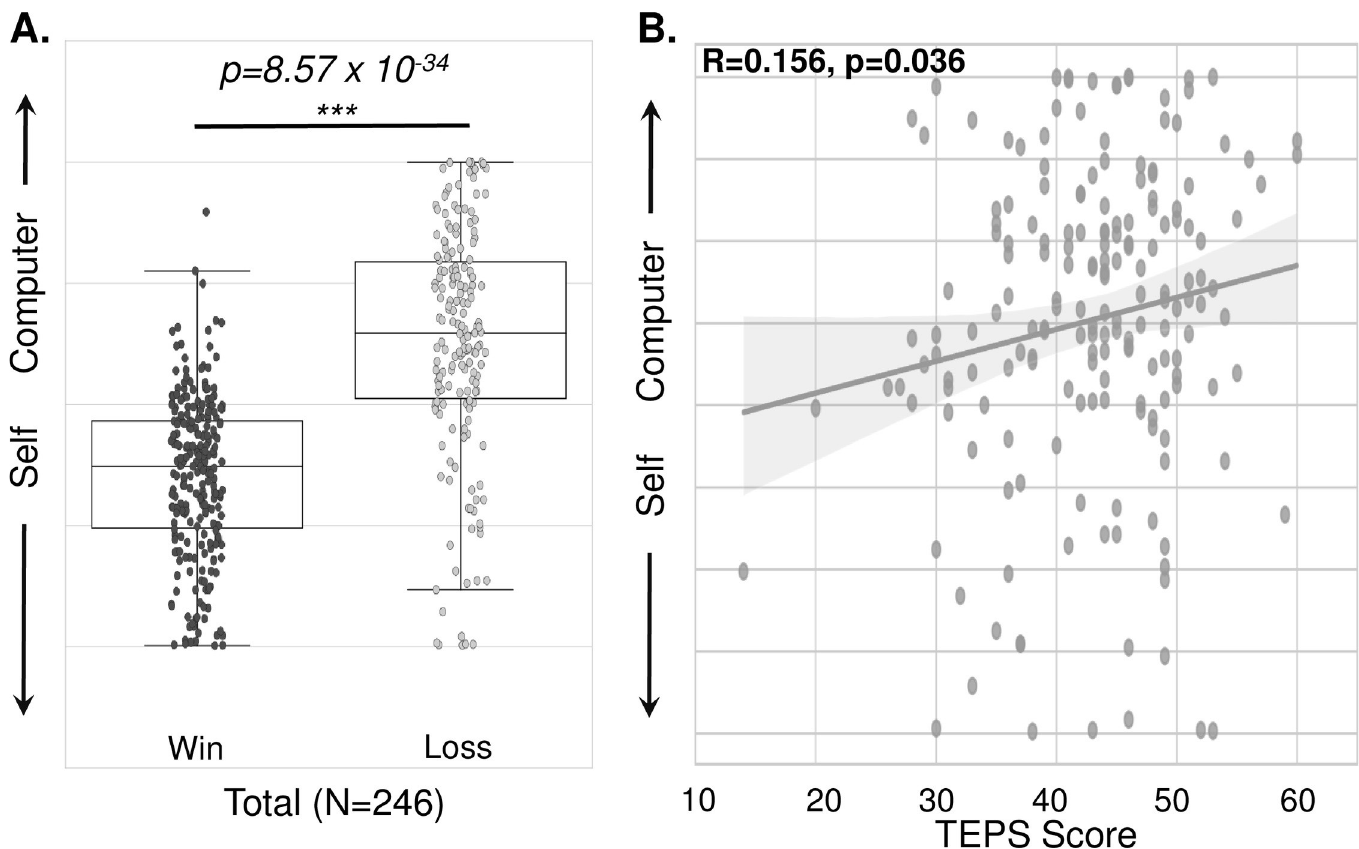
Fig 5. Higher positive feedback-dependent agency replicated in online sample. A, Agency ratings plotted following positive-win and negative-loss feedback during Ambiguous trials for all subjects in the online session (N = 246). B, Agency ratings plotted following negative-loss feedback during Ambiguous trials against Temporal Experience of Please Scale (TEPS) anticipatory sub-score for the online sample (N = 246). Higher TEPS scores represent higher pleasure ratings, thus being inversely related to anhedonia.